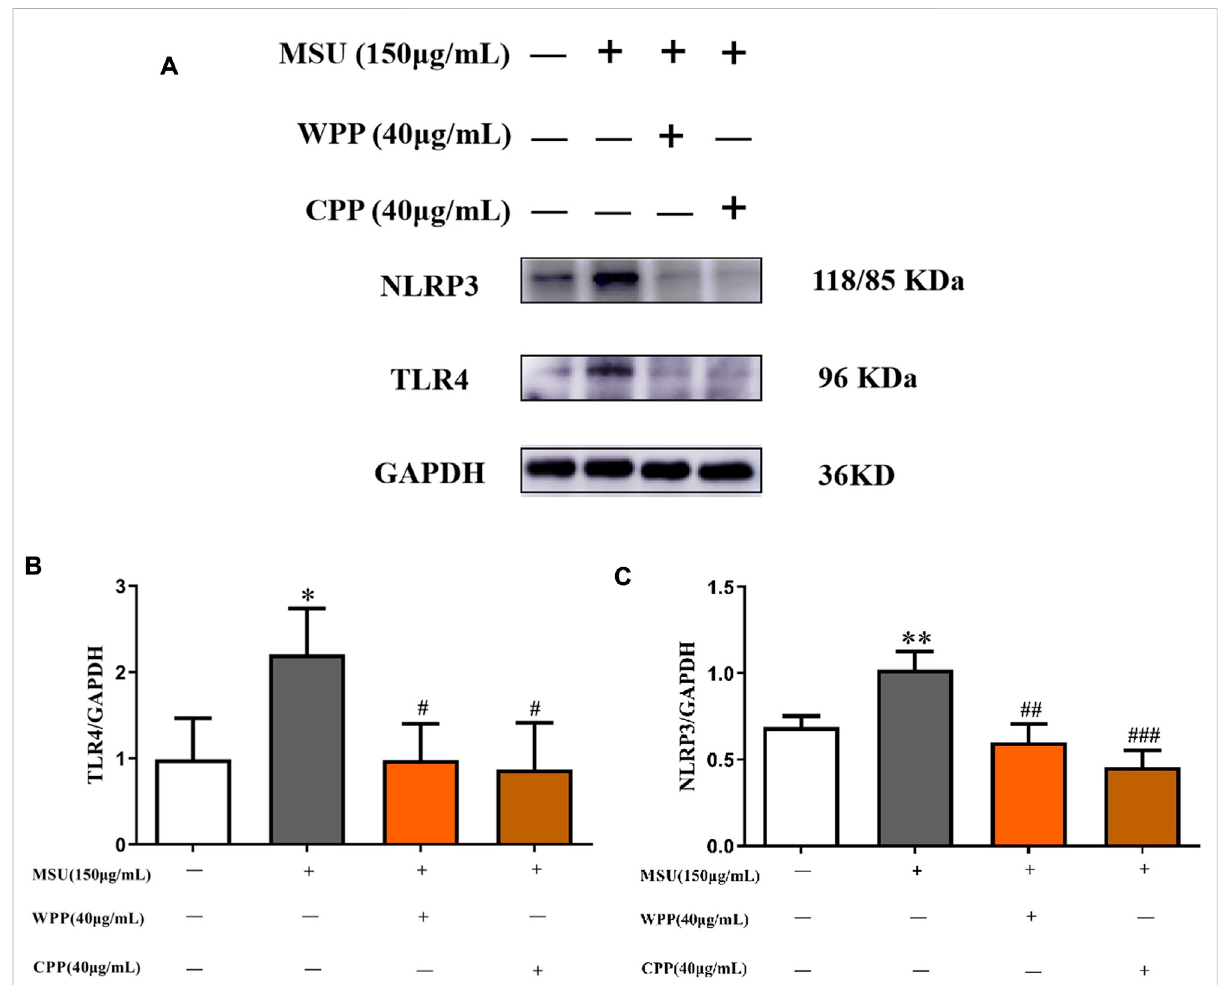
FIGURE 4 Western blotting was used to detect the effect of WPP and CPP on the protein expression of TLR4 and NLRP3 (A) , and ImageJ was used to measurethegrayvalueoftheproteinbands (B,C) ,* p < 0.05,** p < 0.01vs.thecontrolgroup; # p < 0.05, ## p < 0.01, ### p < 0.001vs.themodelgroup; n =